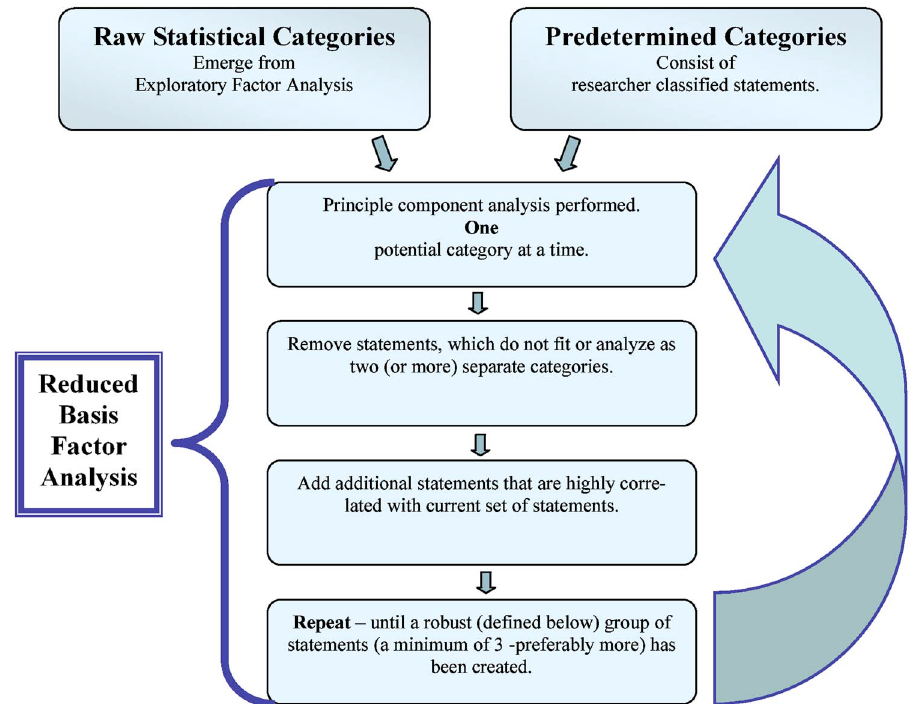
FIG. 1. (cid:1) Color (cid:2) Flowchart depicting reduced basis factor analysis: Process for choosing